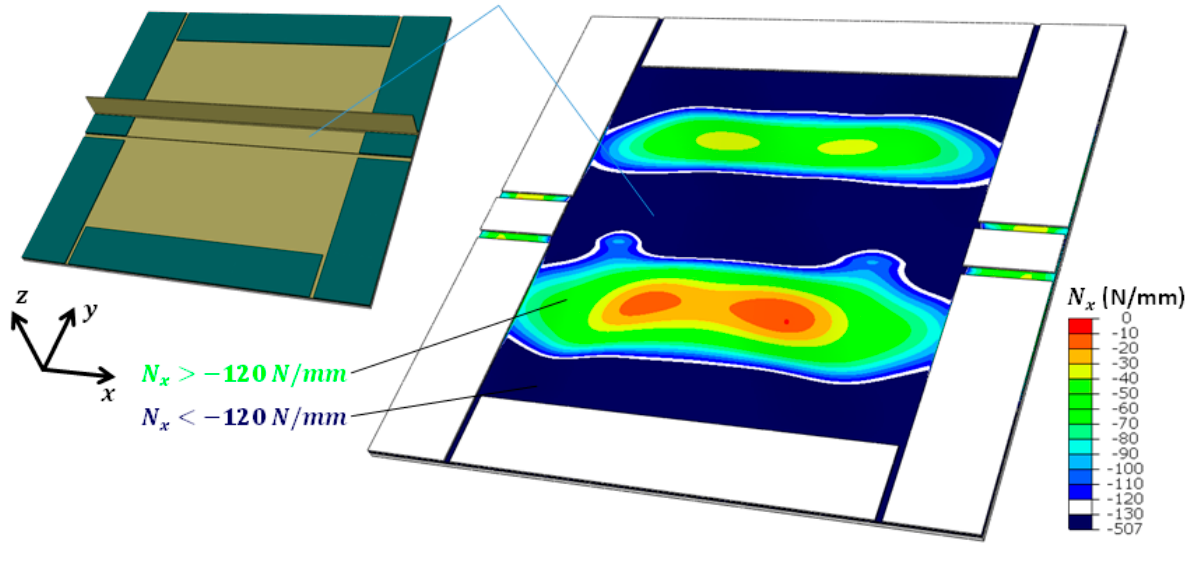
(cid:1) (cid:0) for ∆ U = 1.25 mm ; ε G xx = − 2500 µε , showing a highly